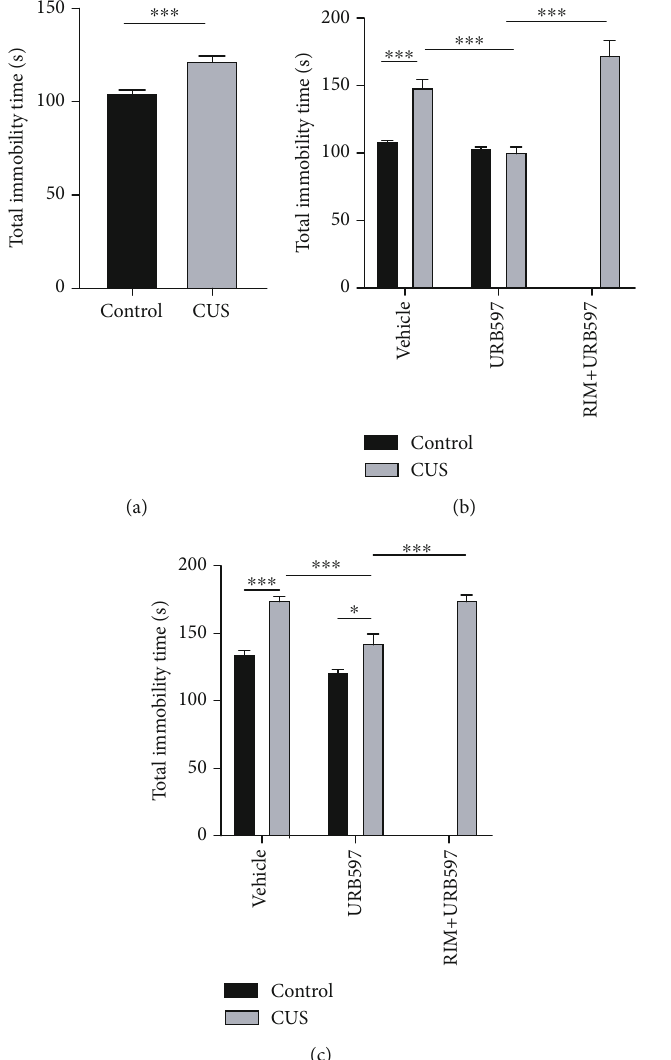
Figure 4: Total immobility time (s) in FST. (a) Evaluations at days 0 and 15, representing control and CUS conditions, ∗∗∗ p ≤ 0 : 001 . Unpaired Student ’ s t -test. Evaluations at day 22 (b) and day 28 (c) under di ff erent experimental treatment conditions. The columns represent the mean of total immobility time ± SEM , n = 12 /group; ∗ p ≤ 0 : 05 ; ∗∗∗ p ≤ 0 : 001 . Two-way ANOVA post hoc Holm-Sidak ’